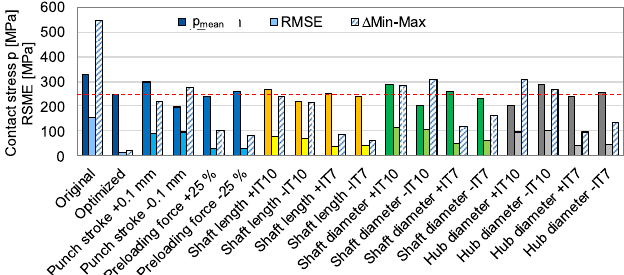
Fig. 9. Contact-stress distribution with respect to shaft-length tolerances.